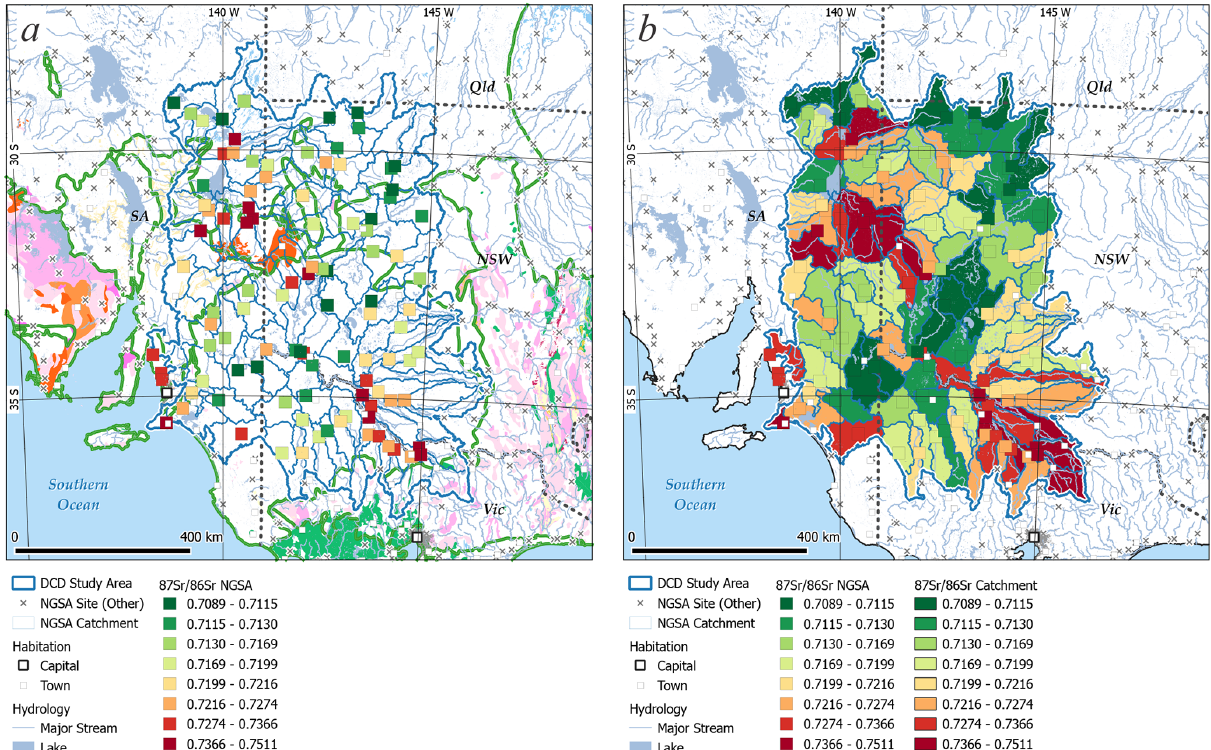
Figure 4. Strontium isoscape for the Darling–Curnamona–Delamerian (DCD) Sr isotope study area with data points classed by quantiles and overlain (a) on geological regions (double green outlines) from Blake and Kilgour (1998) and surface geology from Raymond et al. (2012) (see Fig. 2a for geology legend); and (b) on catchments coloured by same colour ramp. Data are classified in eight equal quantile classes. Map projection: Albers equal